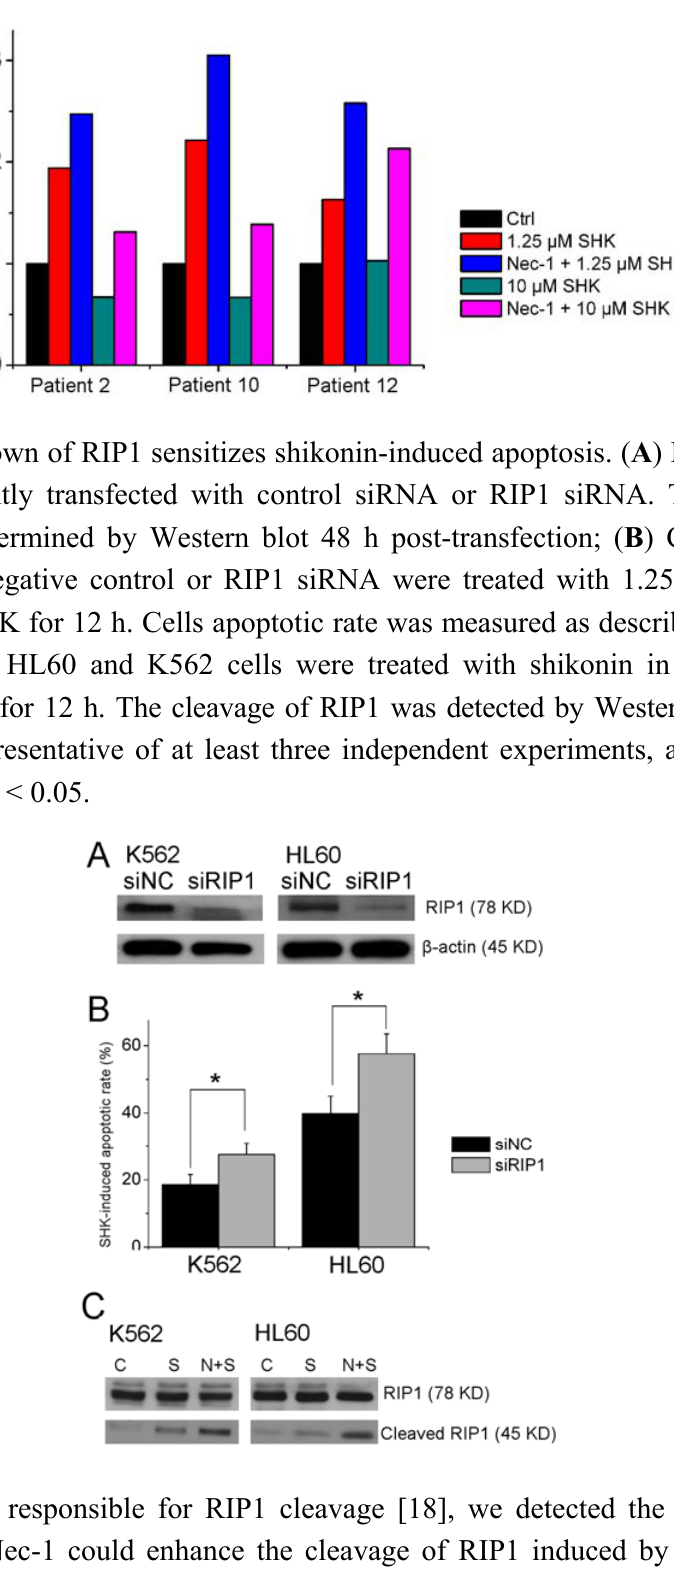
Figure 3. Nec-1 enhances shikonin-induced apoptosis via increasing caspase activation in primary leukemias. Primary leukemia cells were isolated and treated with shikonin in the absence or presence of Nec-1 for 12 h. Caspase-3 activation was determined as described in Materials and Methods. Three representative samples are shown out of 14 tested.